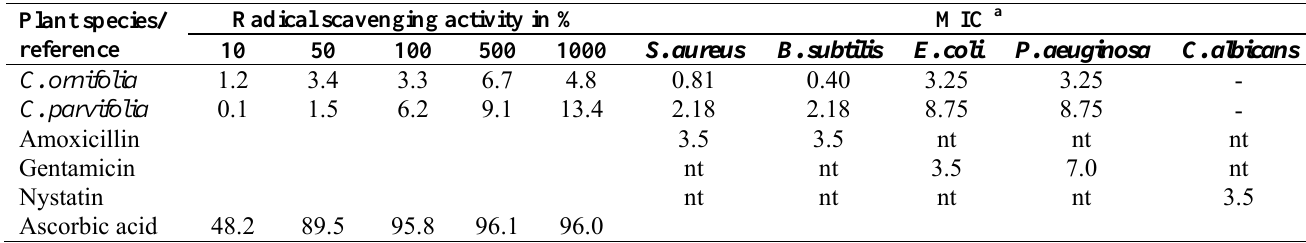
Table 2. Antimicrobial activity (MIC-values) and free radical scavenging activity of the investigated essential